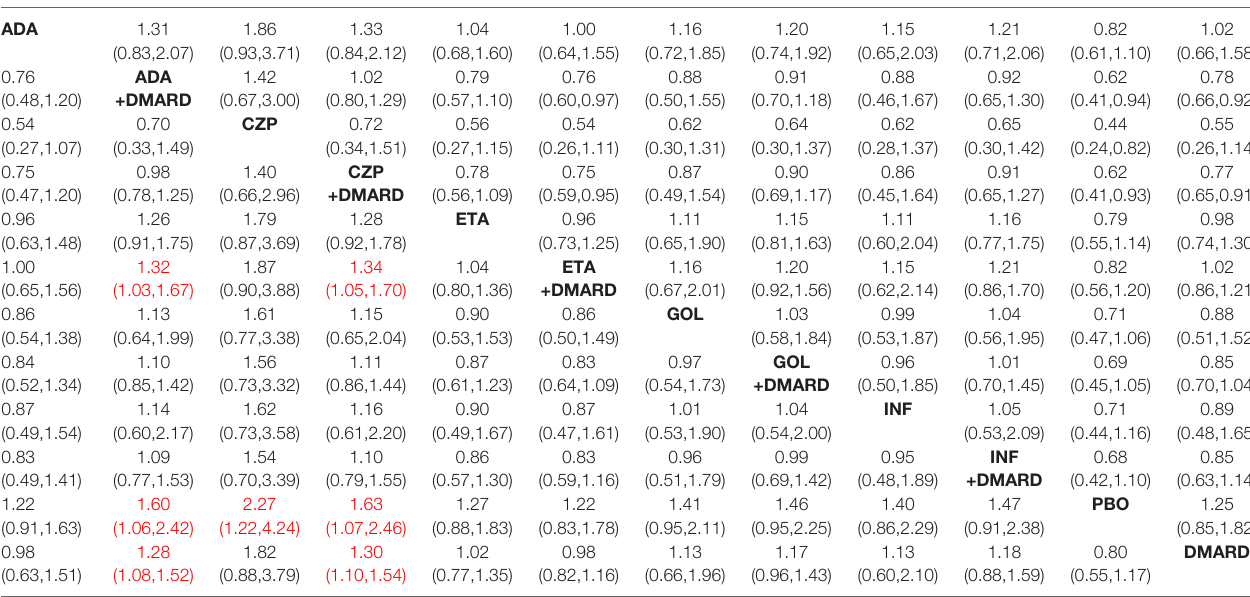
TABLE 2 | OR of adverse events for 12 therapies.